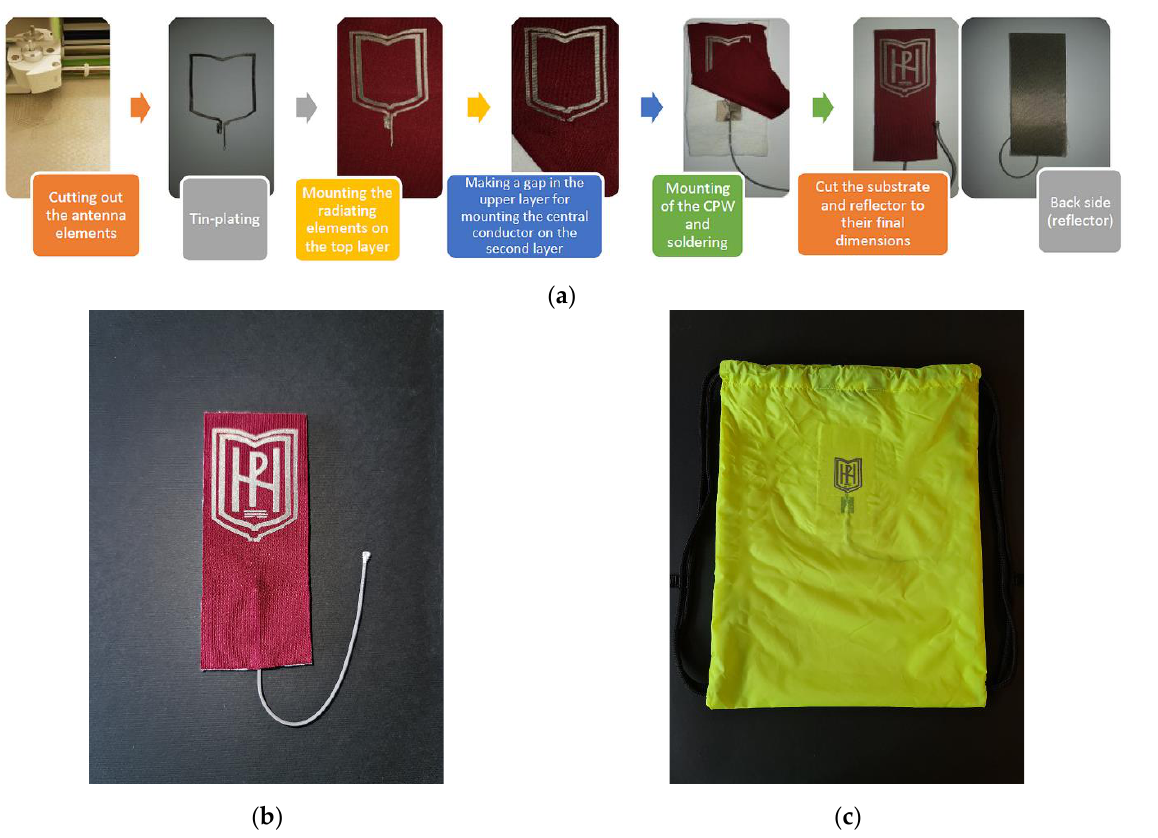
Figure 3. Antenna prototype fabrication process: ( a ) block diagram; ( b ) photograph of the fabricated prototype 1, and ( c ) photograph of the fabricated prototype 2 — integrated into a backpack.